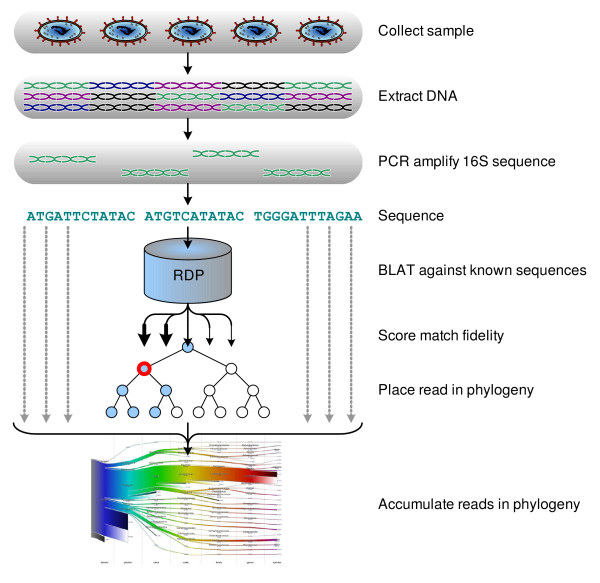
Methodology overview. After collecting the bacterial sample, DNA is extracted followed by amplification of 16S rDNA using universal primers. These fragments are then sequenced with high-throughput Pyrosequencing. Each read is queried against a database of known 16S rDNA sequence (mostly obtained from the Ribosomal Database Project) using the program BLAT and assigned to the most specific and confident node in the phylogeny. Accumulating all the reads in this fashion yields a weighted phylogenetic tree characterizing the bacterial content of the sample.